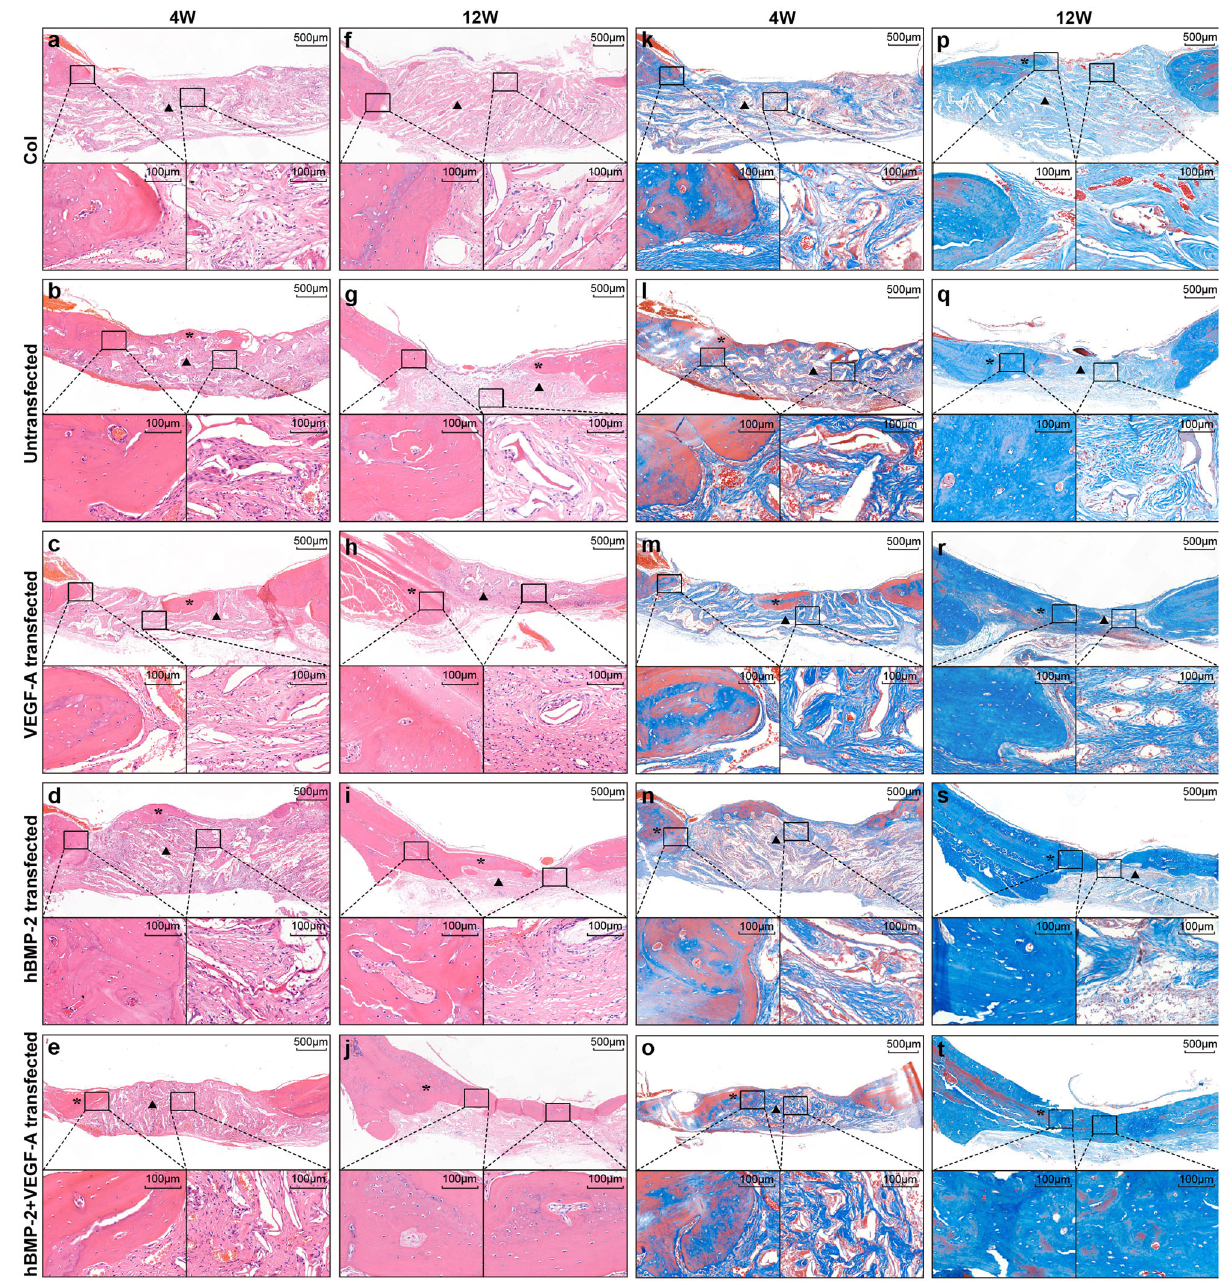
Fig. 4 Histological evaluation of bone defects and repair following injury and scaffold implantation. a – j Hematoxylin and eosin staining at the location of the cranial defect 4weeks ( a – e ) and 12 weeks ( f – j ) post-implantation. Note less neo-bone formation in the control and single treatment groups (asterisks). k – t Masons trichrome staining at the location of the cranial defect 4 wks ( k – o ) and 12 wks ( p – t ) post-treatment. At 4weeks post-treatment increased levels of bone-forming osteoids were detected in modRNA treatment groups, as indicated by blue staining ( n , o ). At 12weeks post-treatment there is more mineralized bone in the modRNA treatment groups as indicated by blue staining ( s , t ). The most different level of bone repair was found in the group of scaffolds embedded with 1B1V transfected BMSCs. (Note: in all images the asterisks represent callus tissue; the arrowheads represent fi brous connective